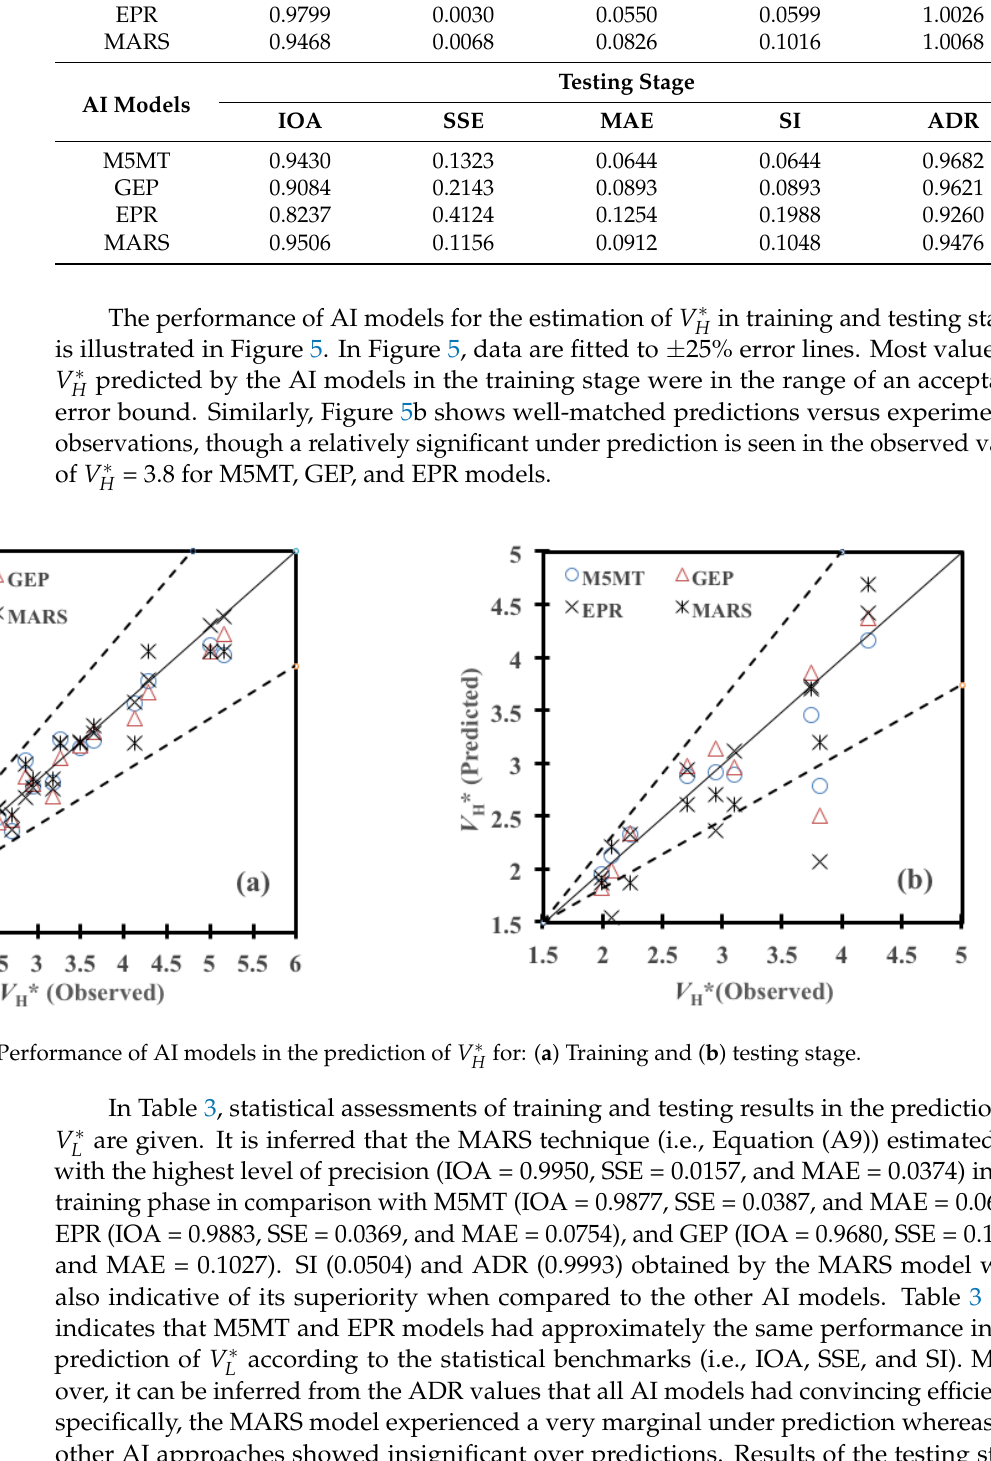
training phase in comparison with M5MT (IOA = 0.9877, SSE = 0.0387, and MAE = 0.0672), EPR (IOA = 0.9883, SSE = 0.0369, and MAE = 0.0754), and GEP (IOA = 0.9680, SSE = 0.1001, and MAE = 0.1027). SI (0.0504) and ADR (0.9993) obtained by the MARS model